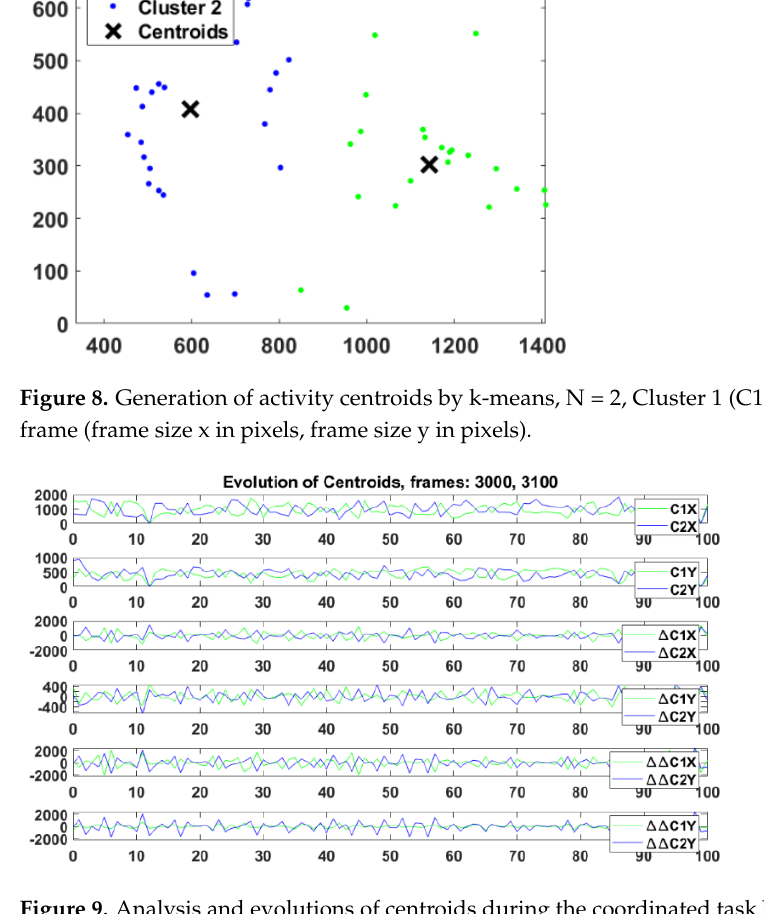
Figure 9. Analysis and evolutions of centroids during the coordinated task between the human and the Cobots, C1 and its coordinates and variation in green, and C2 and its coordinates and variation in blue. The variations along the time were calculated (difference between two consecutive frames) ∆C1 and ∆C2, and ∆∆C1 and ∆∆C2 were calculated for both coordinates (X, Y). Figure 10 shows the results obtained for the three UCs by a ROC analysis of the SVM models of the centroids (C1, C2 by SVM) during the performance of the UCs (the real and simulated use cases): (a) UC1: coordinated Cobot learning task in green. (b) UC2: Simulated stressed worker in yellow. (c) UC3: Risky behaviour of Cobots in red. The ROCs showed clear differences for the UCs. Indeed, the values of Area Under the Curve (AUC) show the highest CL for AUC = 0.5 and an increase in this value for stress and risk